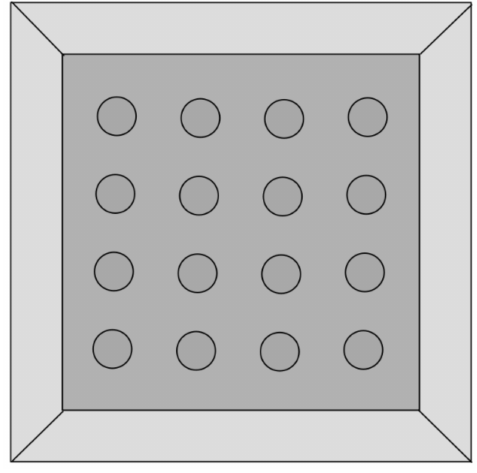
Figure 1. Hole–board apparatus (view from